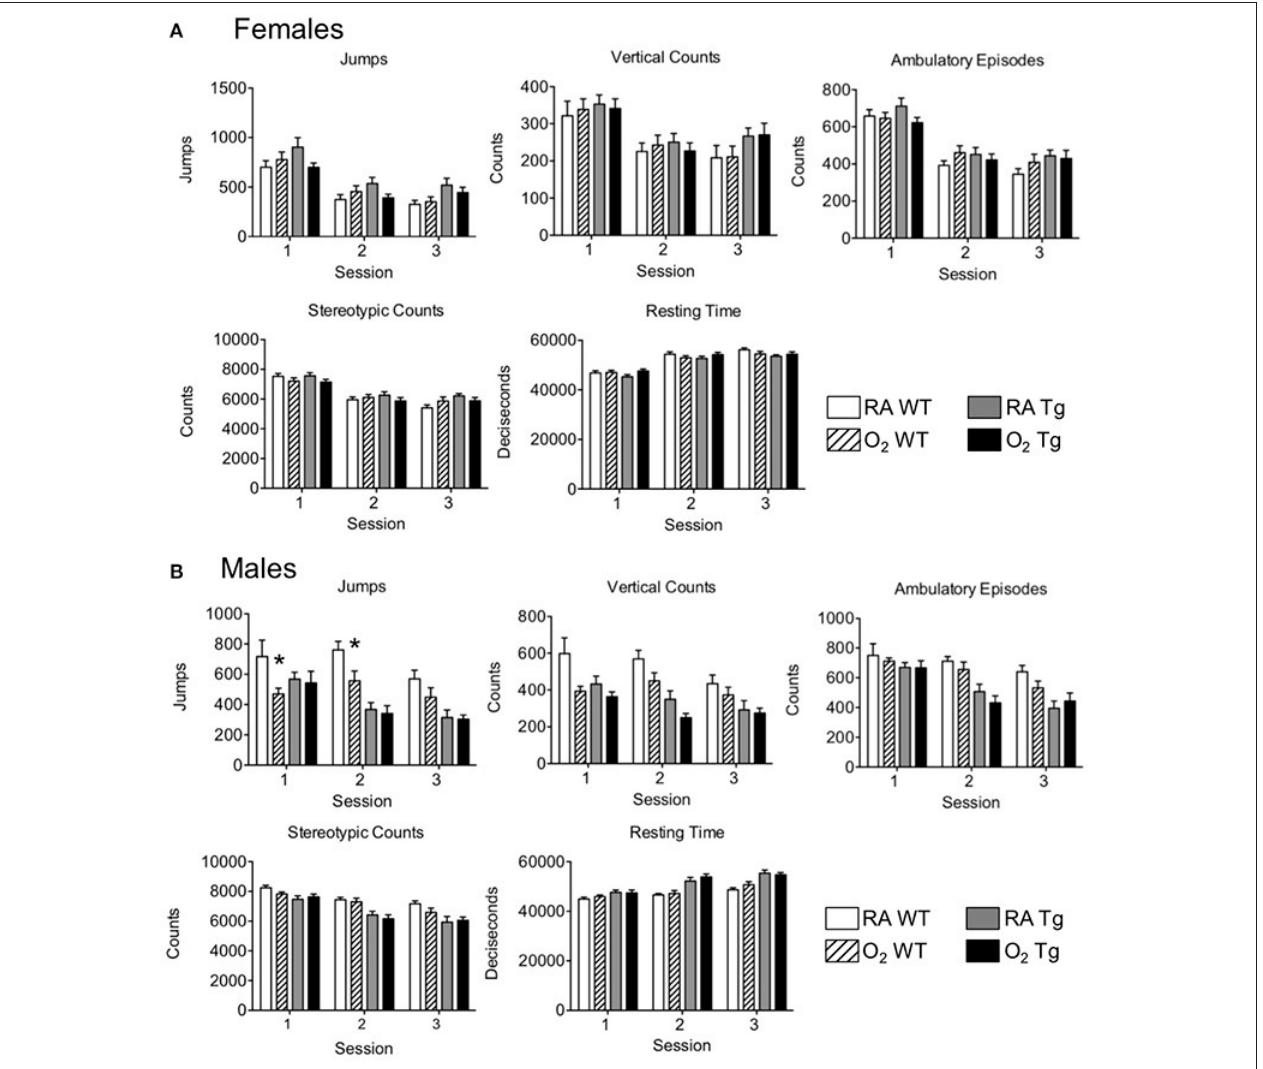
FIGURE 3 | Exposure to neonatal hyperoxia does not affect locomotor activity in adult mice. Locomotor activity testing was evaluated in adult (A) female and (B) male wild type (WT) and Sftpc EC − SOD transgenic (Tg) mice (8–10 weeks of age) exposed to room air (RA) or 100% oxygen (O 2 ) during postnatal days (PND) 0–4. Jumps, vertical counts, ambulatory episodes, stereotypic counts, and resting time were quantified in three 60-min sessions occurring once per day on three consecutive days ( n = 9–10 mice per group, * P < 0.05 when compared to WT mice exposed to room air as